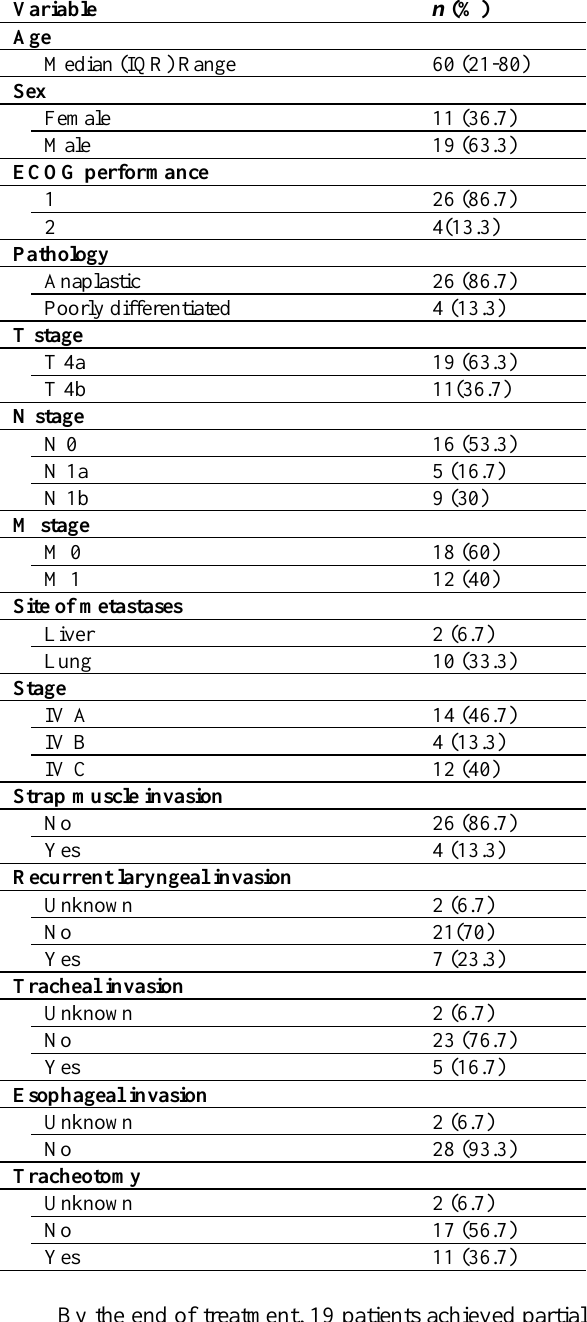
Table 1: Patient characteristics (n=30)